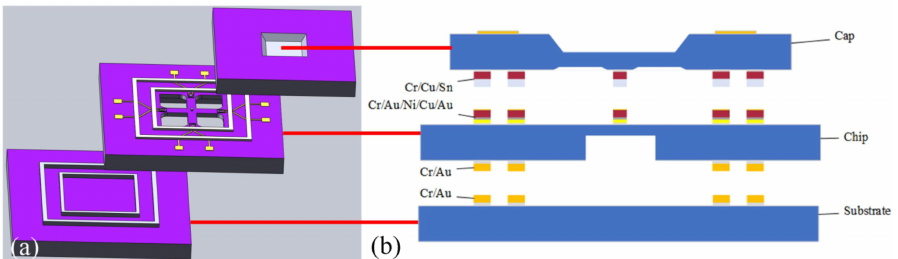
Figure 1. Schematic of test structures. ( a ) Graphene sensor structure (core crossbeam dimensions: 900 µ m × 200 µ m × 90 µ m). ( b ) Bonding structure.